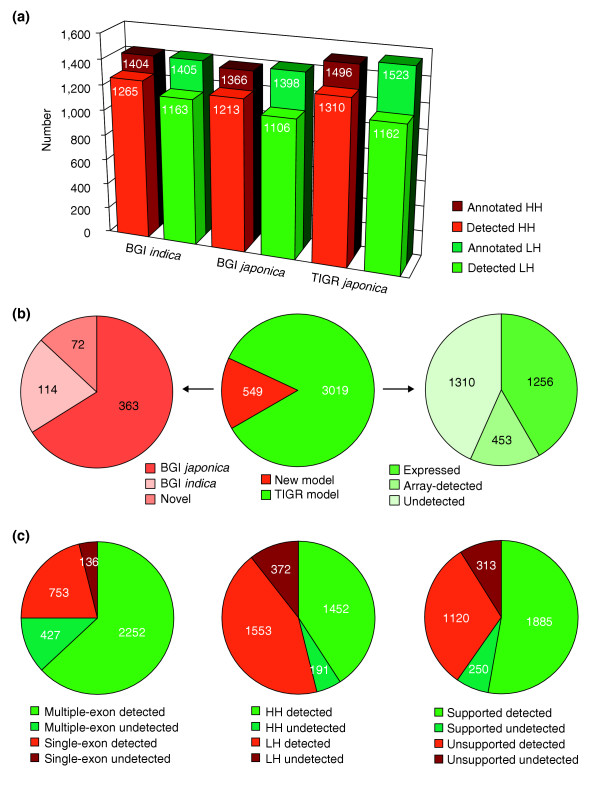
Comparison and integration of chromosome 10 gene models. (a) Number of annotated and array-detected high homology (HH) and low homology (LH) models in the BGI indica, BGI japonica, and TIGR japonica annotations. (b) The 549 new gene models were combined with the 3,019 TIGR models. Origins of the new models are shown on the left. Expression support for the TIGR models is shown on the right. Expressed, models matching full-length cDNA/EST; array-detected, models not supported by the expressed sequences but detected by microarray; undetected, models neither supported by expressed sequences nor detected by microarray. (c) Classification of integrated japonica chromosome 10 gene models based on tiling array detection and exon number (left), homology to Arabidopsis genes (middle), and previous expression or homology support to the models (right).